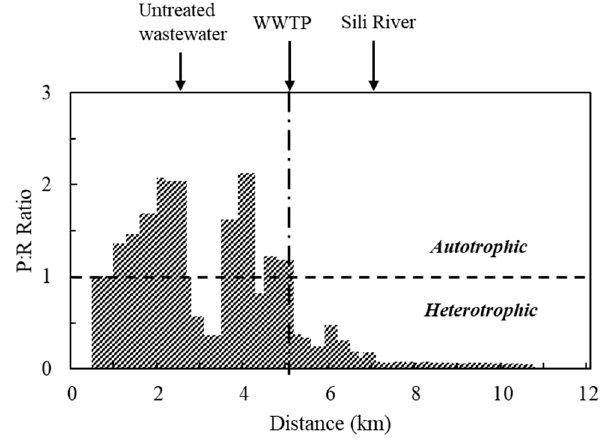
Figure 7. Longitudinal primary production to the respiration ratio and metabolism condition.